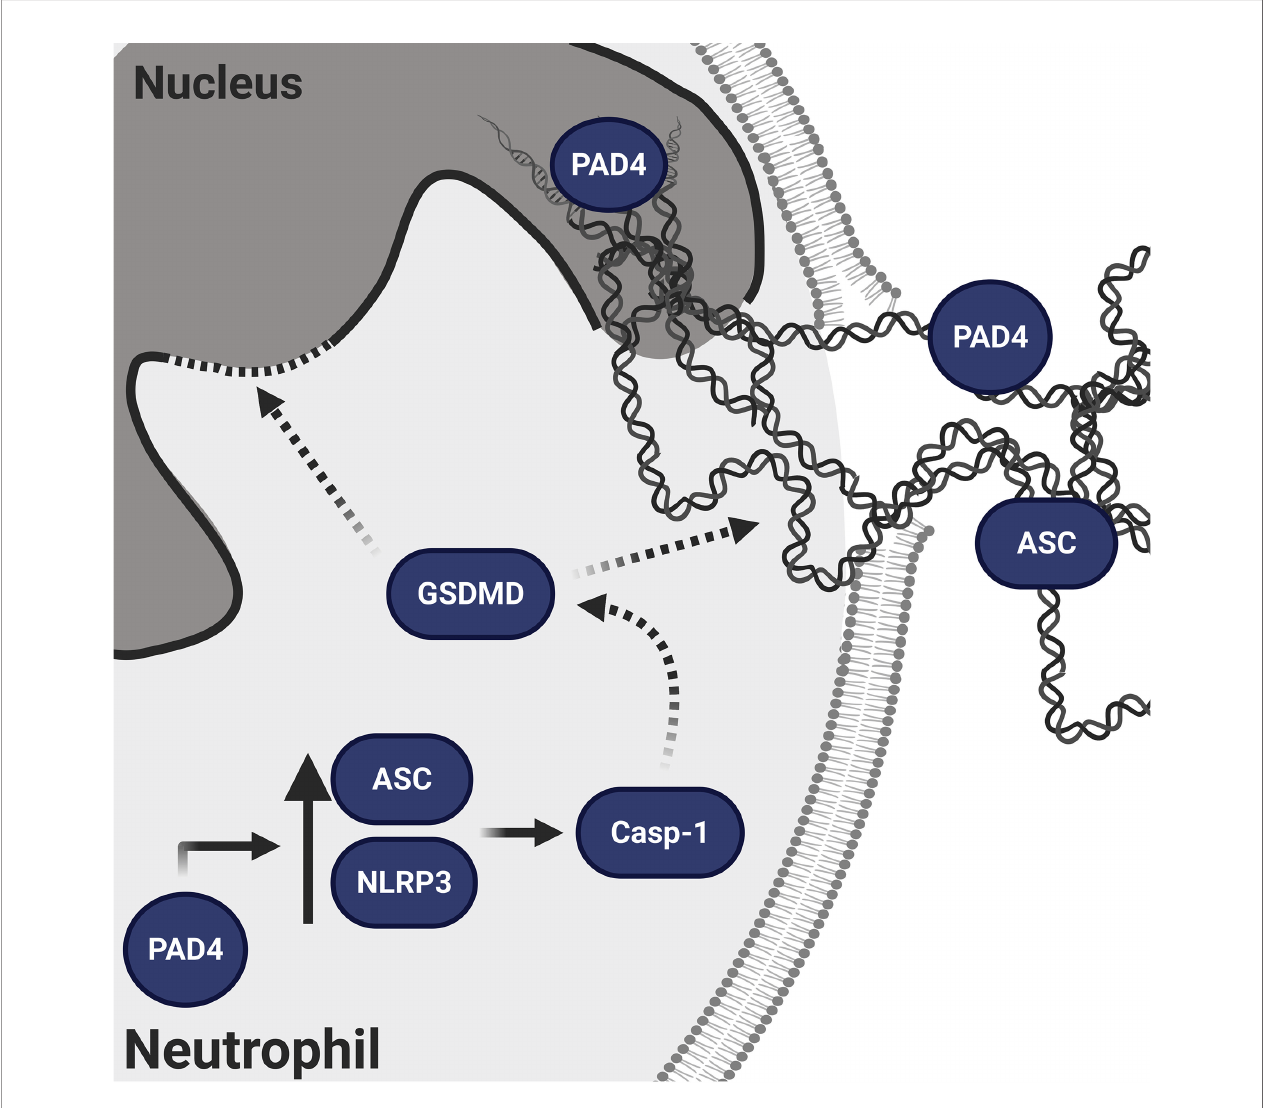
FIGURE 6 | Schematic representation of the proposed mechanism of NLRP3/PAD4-induced NETosis in the absence of infection. PAD4 is present both in the nucleus and cytoplasm (15). In the nucleus, PAD4 orchestrates chromatin decondensation, whereas in the cytoplasm, PAD4 increases NLRP3 and ASC protein levels post-transcriptionally, thus favoring NLRP3 in fl ammasome/ASC speck assembly. The NLRP3 in fl ammasome activates caspase-1, which is known to generate the N-terminal fragment of GSDMD pore that facilitates nuclear expansion (49) and nuclear permeabilization (50). In addition to GSDMD, caspase-1 has many other intracellular substrates (54) and therefore its activation could support the cytoskeletal and nuclear disassembly necessary for NETosis